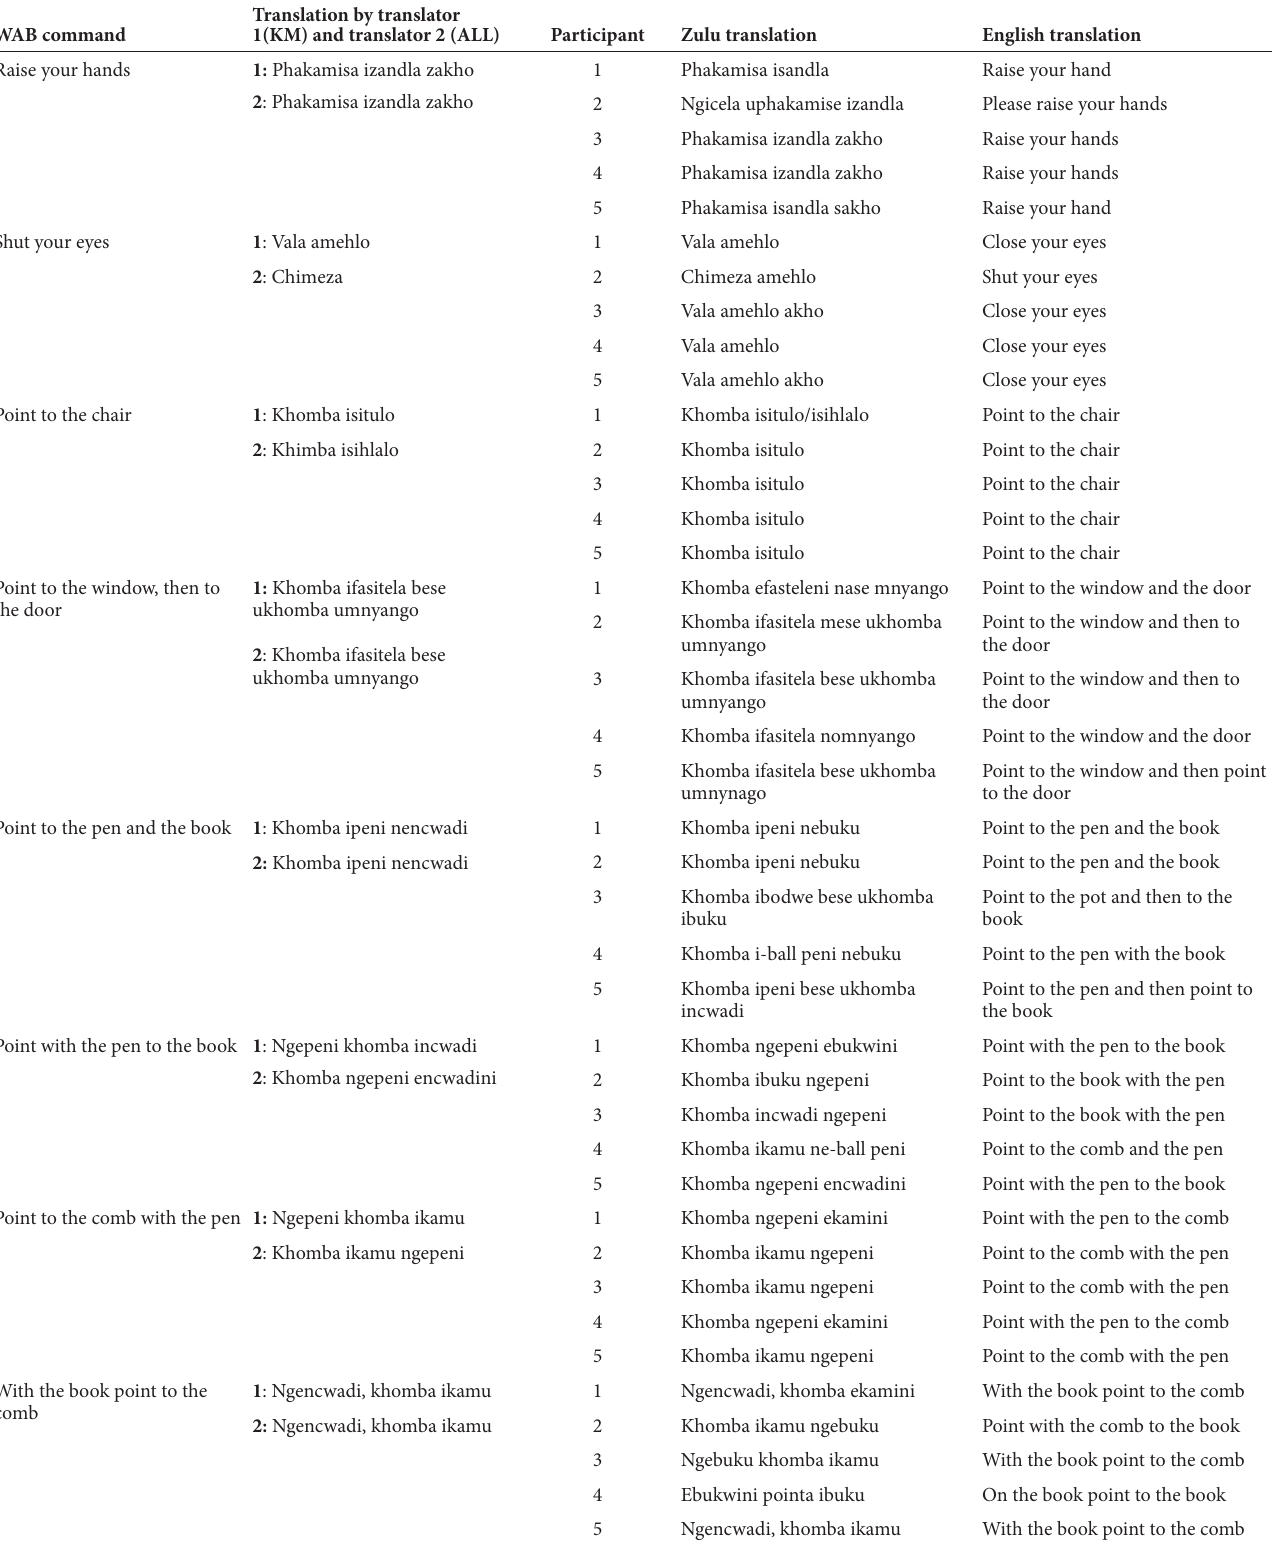
Table 4. Translation of the sequential commands subtest of the WAB WAB